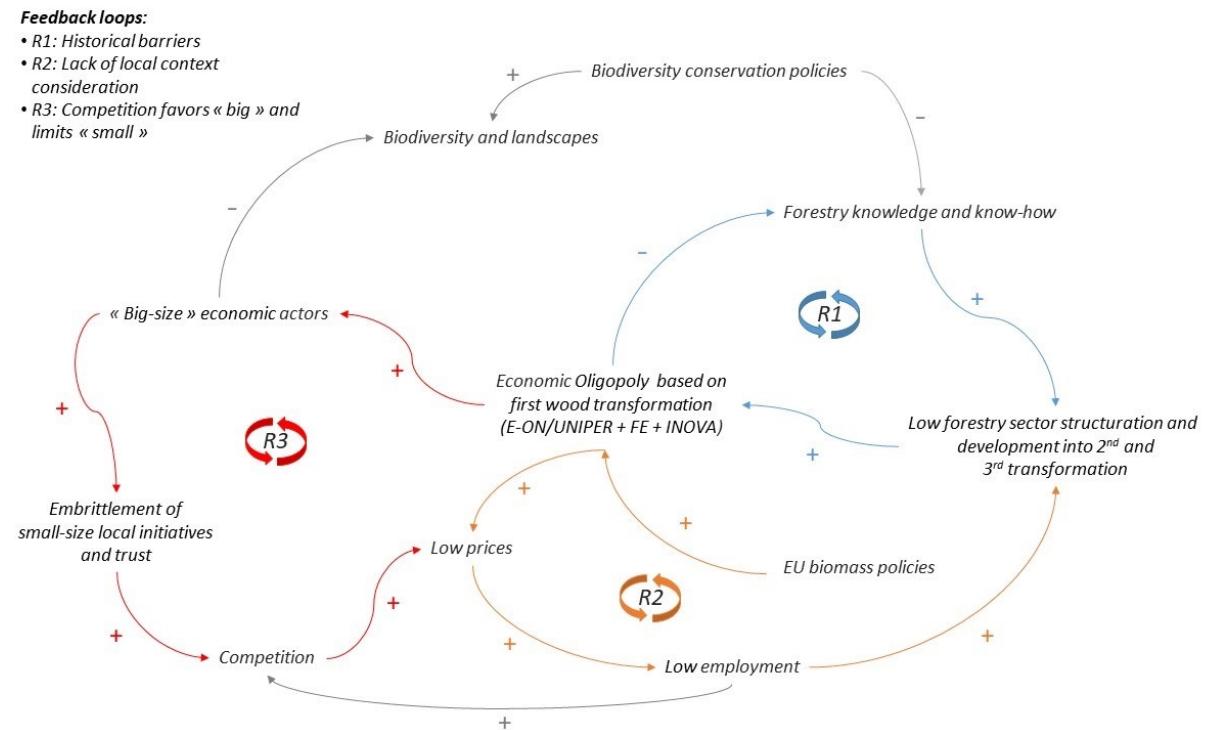
Figure 5. Causal-loop diagram summarizing the local dynamics of the PACA forest system. The sign + describes an enhancing effect and the sign − describes a limiting effect. The blue arrows are associated to the feedback process R1, the orange arrows are associated to the feedback process of R2 and the red arrows are associated to the feedback process R3. The grey arrows represent simple cause-effect dynamics in the system.